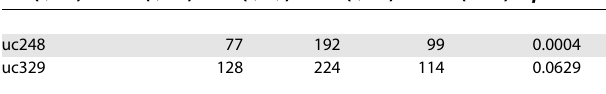
Table 2. Summary of Observed Offspring from Heterozygous 3 Heterozygous Mouse